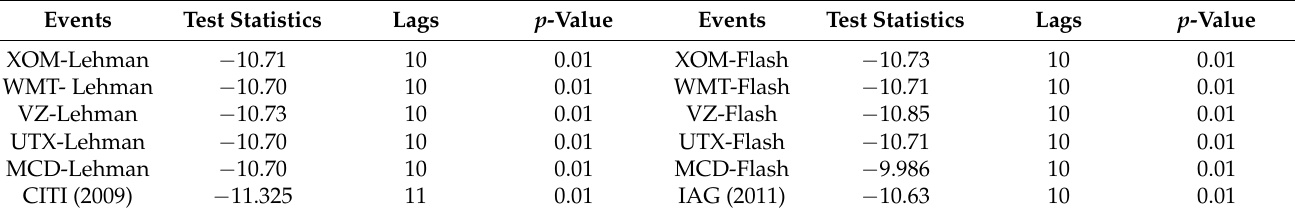
Table 1. ADF t-statistics test.